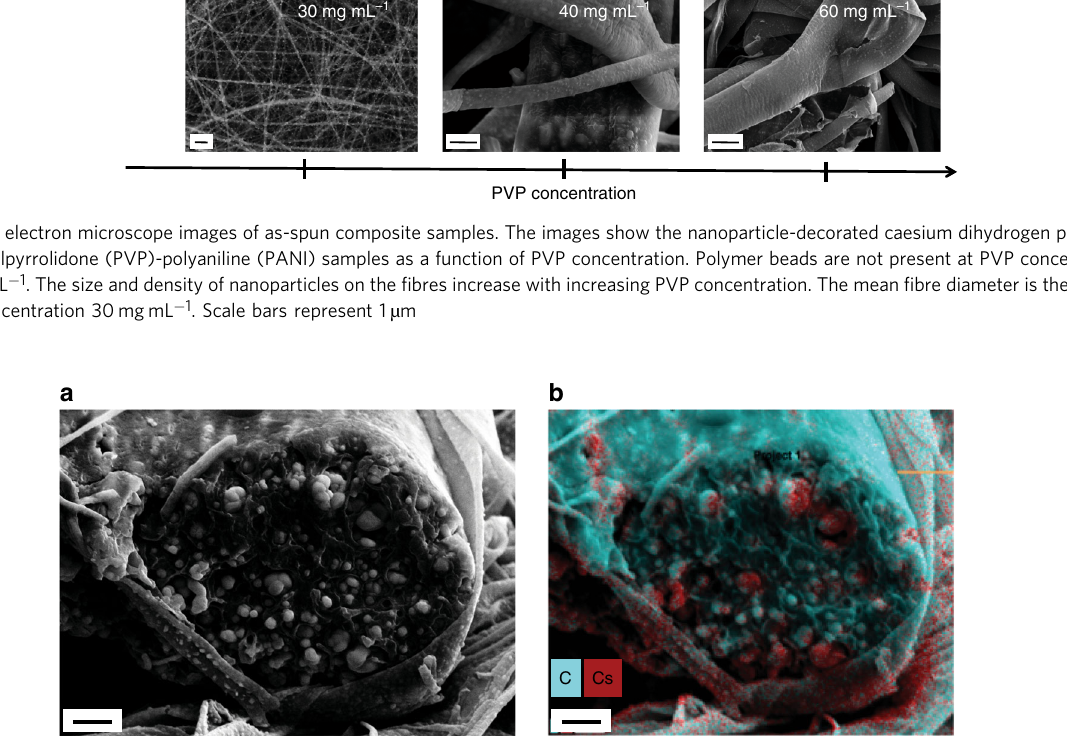
Fig. 3 Cross-section scanning electron microscope (SEM) image. The image shows a large electrospun caesium dihydrogen phosphate (CDP)- polyvinylpyrrolidone (PVP)-polyaniline (PANI) fi bre with CDP particles inside the fi bre and on the surface. a SEM image showing CDP particles ranging from 190 nm to 1.2 µ m inside the electrospun fi bre. b Energy dispersive X-Ray spectroscopy map of the same cross-section, showing the caesium (Cs) in red, and the carbon (C) in turquoise. Scale bars are 2 µ with different sizes (from 190 nm to 1.2 µm, with an average of (Fig. 3b). It also appears that the fi bre surface is coated. This